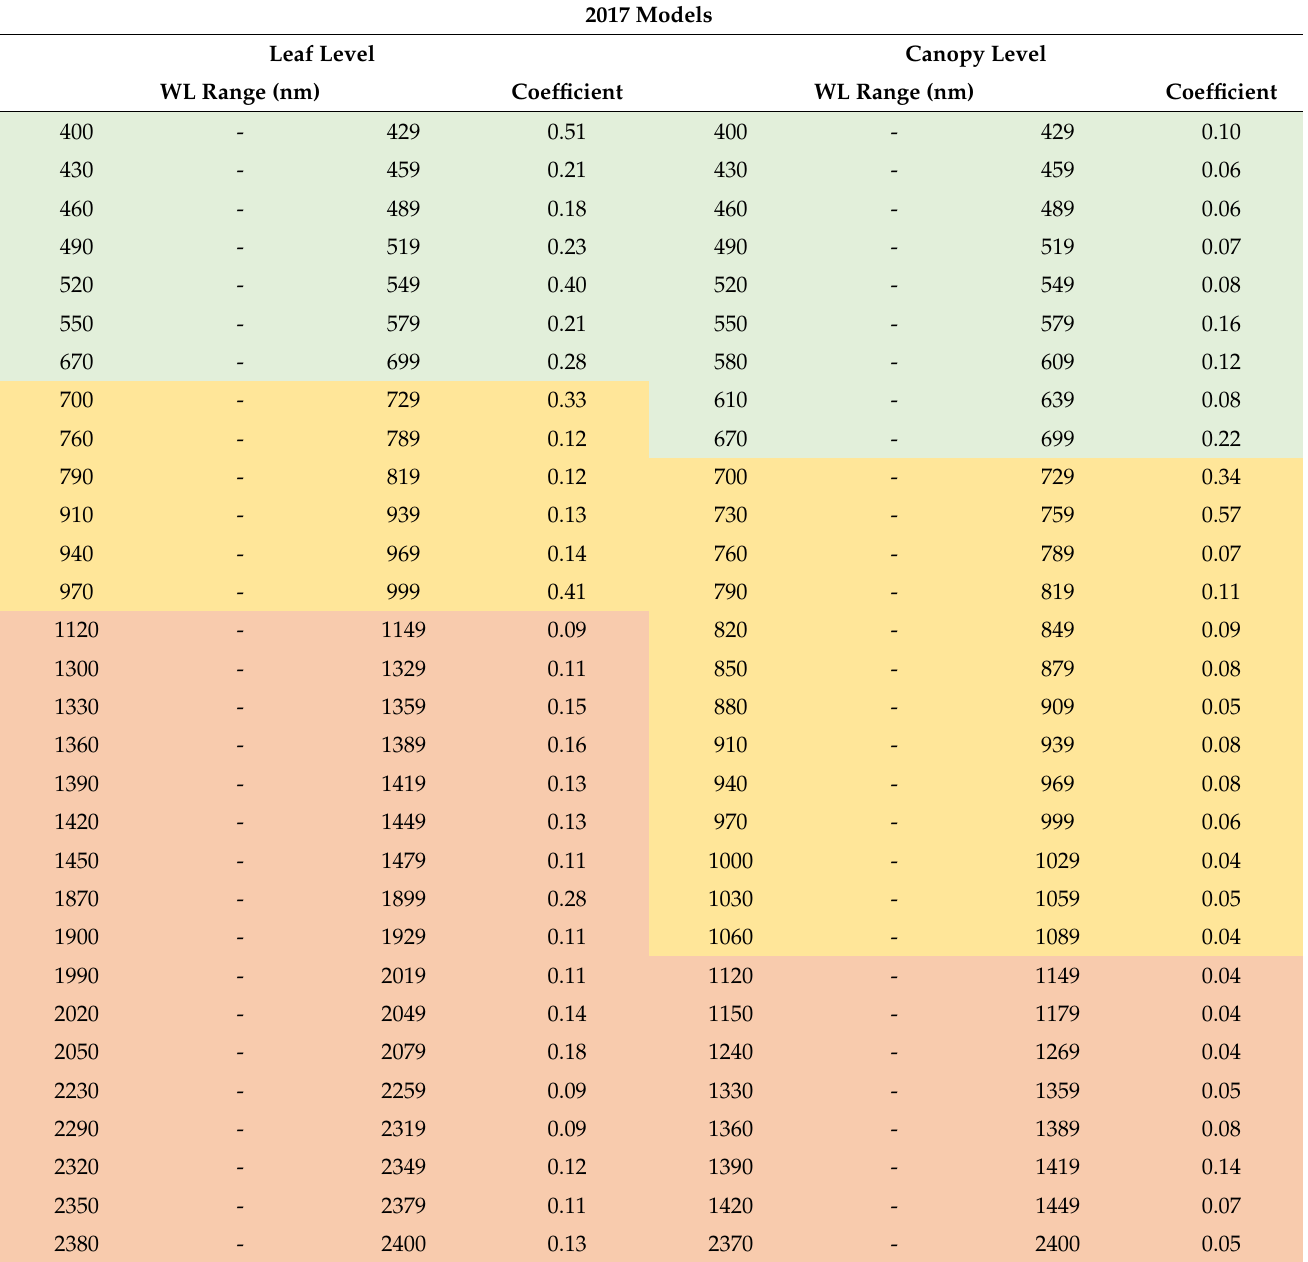
Table A6. Top 30 standardized coefficient values and their respective wavelength ranges from 2017 leaf and canopy models. The coefficients values displayed in this table represent the average standardized coefficient value every 30nm, as described by the wavelength range (WL Range (nm)). Colors highlighting the three main areas of the full-spectral range: green, visible (VIS); orange, near-infrared (NIR); and red, short-wave infrared